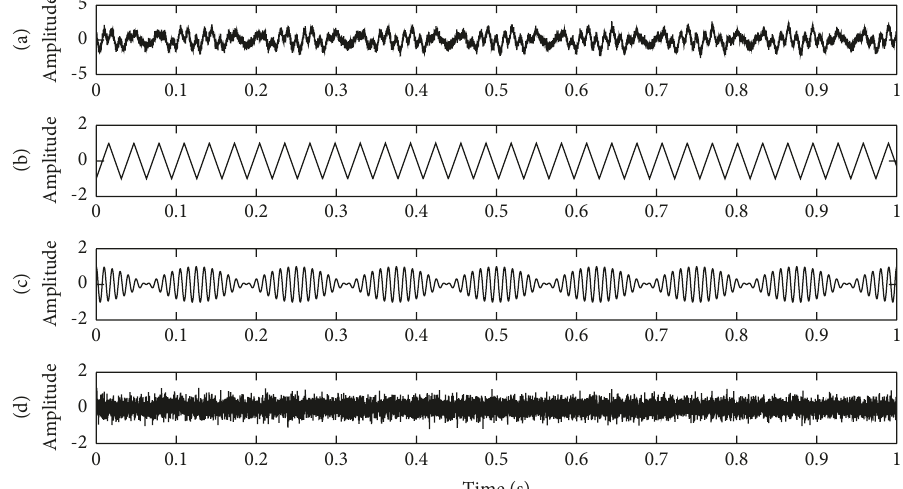
Figure 2: The time-domain waveforms of x ( t ) and the three components. (a) Mixed signal (SNR � 10); (b) sawtooth wave signal; (c) AM- FM signal; (d) noise signal.